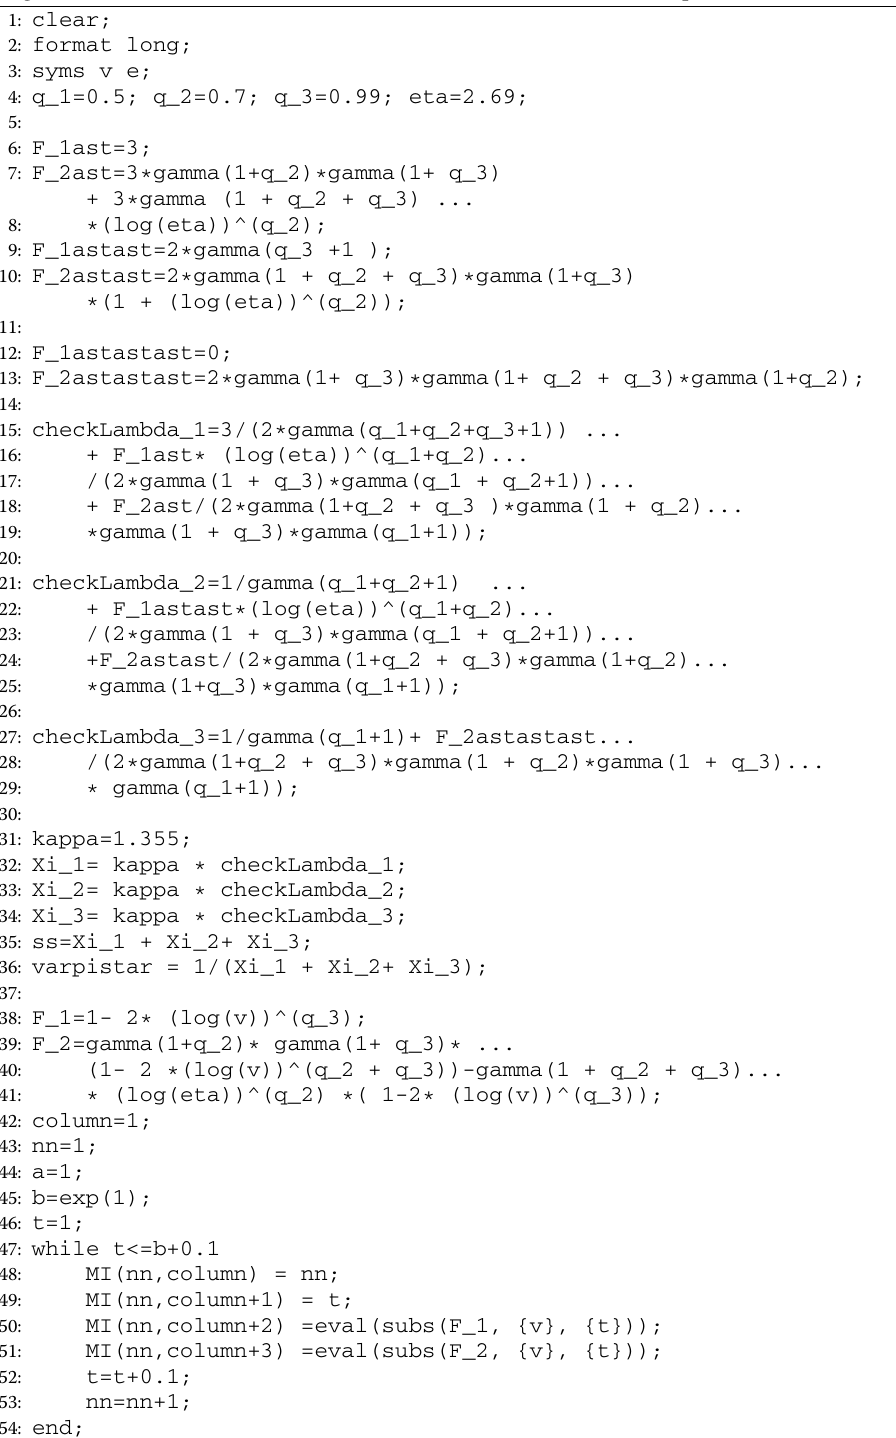
Algorithm 1 MATLAB lines for calculation of all variables in Example